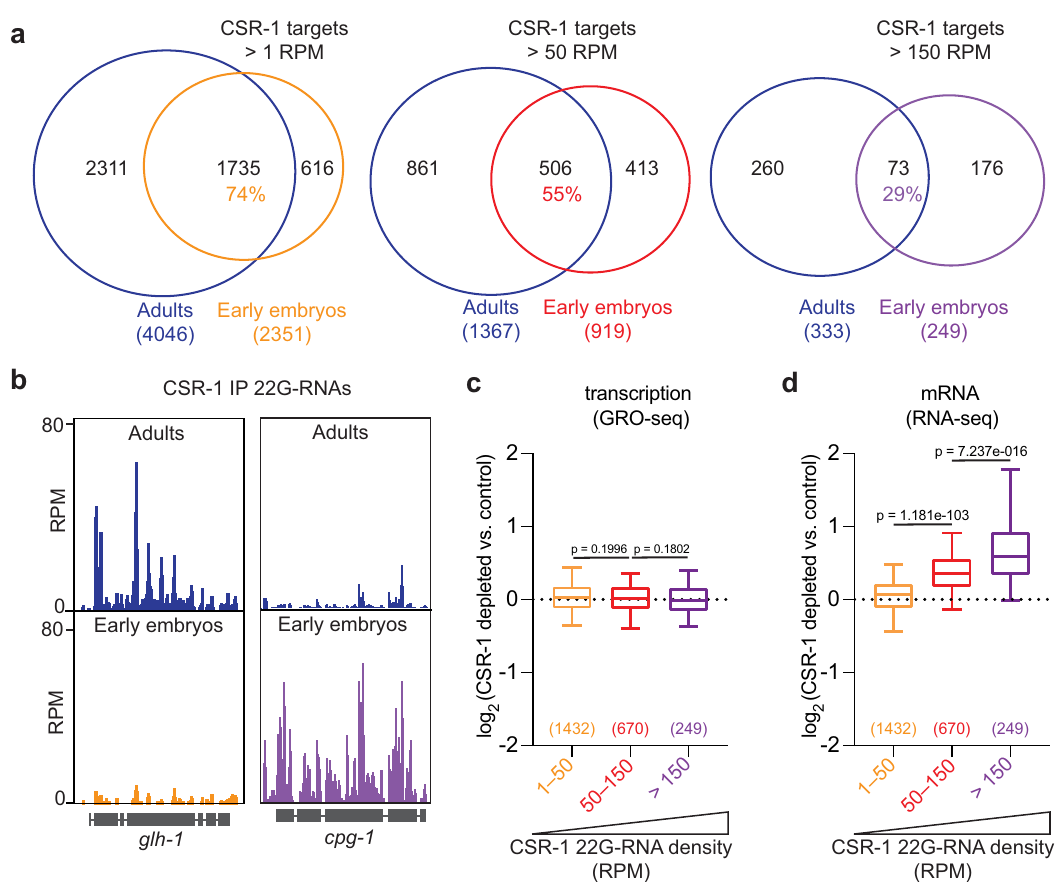
Fig. 2 CSR-1 post-transcriptionally regulates its targets in the embryo. a Venn diagram showing the overlap between CSR-1 targets in adults and in early embryos. A gene is considered a CSR-1 target when the ratio between normalized 22G-RNAs from CSR-1 immunoprecipitation and the total RNA in the input is at least 2. We have selected three categories of CSR-1 targets based on the density (reads per million, RPM) of 22G-RNAs from CSR-1 immunoprecipitation: CSR-1 targets >1 RPM, CSR-1 targets >50 RPM, CSR-1 targets >150 RPM. The number of genes and the percentage of overlapping is indicated. b Genomic view of two CSR-1 target genes showing normalized 22G-RNAs in CSR-1 IPs from adult (top) or early embryos (bottom). c , d Box plots showing the log 2 fold change of nascent RNAs (by GRO-seq) or mRNAs (by RNA-seq) in CSR-1-depleted early embryos compared to control for gene sets of increasing 22G RNA density, 1 – 50 RPM, 50 – 150 RPM, >150 RPM. The line indicates the median value, the box indicates the fi rst and third quartiles, and the whiskers indicate the 5th and 95th percentiles, excluding outliers. Two-tailed P values were calculated using Mann – Whitney – Wilcoxon tests. The sample size n (genes) is indicated in parentheses. Source data are available (Fig. 3a) (Supplementary Data 1), and “ Maternal and zygotic ” mRNAs (1958 genes) whose mRNAs are inherited in 1-cell embryos (TPM, >1) and their levels increase in early or late embryos (Fig. 3a) (Supplementary Data 1).